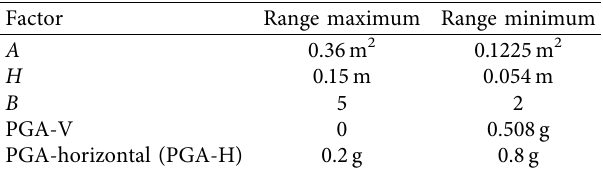
Table 5: Bearing parameters